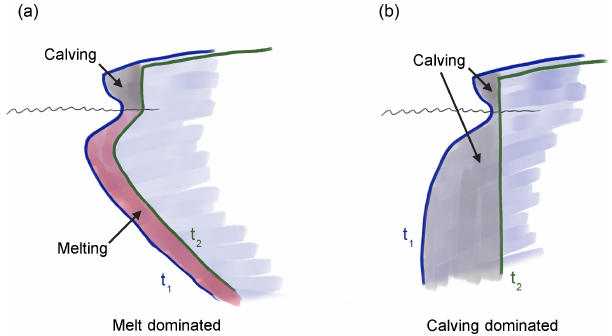
Figure 9. Schematic of two distinct ablation regimes. (a) Melt- dominated regime: the vertical structure of melting due to a rising subglacial discharge plume that entrains warm ambient water re- sults in substantial undercutting of the glacier front (as in profiles A and B in Fig. 8). These front profiles likely do not cause large calv- ing events, with calving mostly confined to the smaller above-water cliff. Profiles are drawn for an earlier time t 1 and a later time t 2 by which the glacier has retreated mostly due to melting. (b) Calving– dominated regime: here the growth of sizable and buoyant underwa- ter feet (as in profiles C and D in Fig. 8) can accelerate calving, with the melt contribution confined to a small region near the water sur- face. Again, profiles are shown at t 1 and t 2 (pre- and post-calving), as part of the “footloose” calving cycle (Wagner et al.,